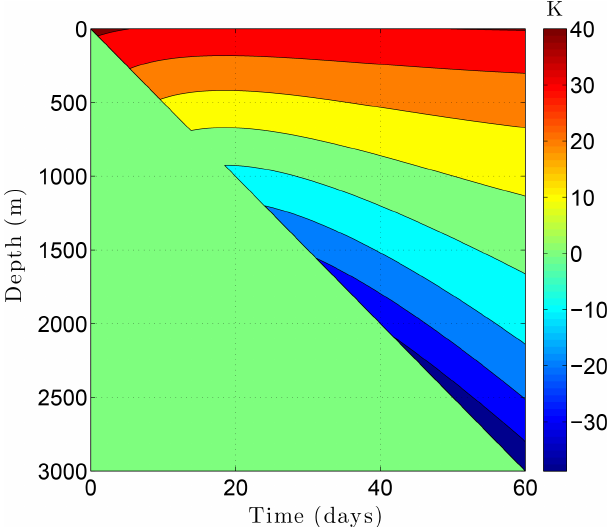
Figure 13. Temperature change (cid:49)T a at the borehole wall while drilling a 3km borehole through the example sedimentary sequence (Fig. 8, Table 5) over a 60-day period. This thermal disturbance, when added to the initial temperature field, provides the boundary condition at the borehole wall during drilling. The drill bit advances from the surface on day 0 to 3km on day 60.